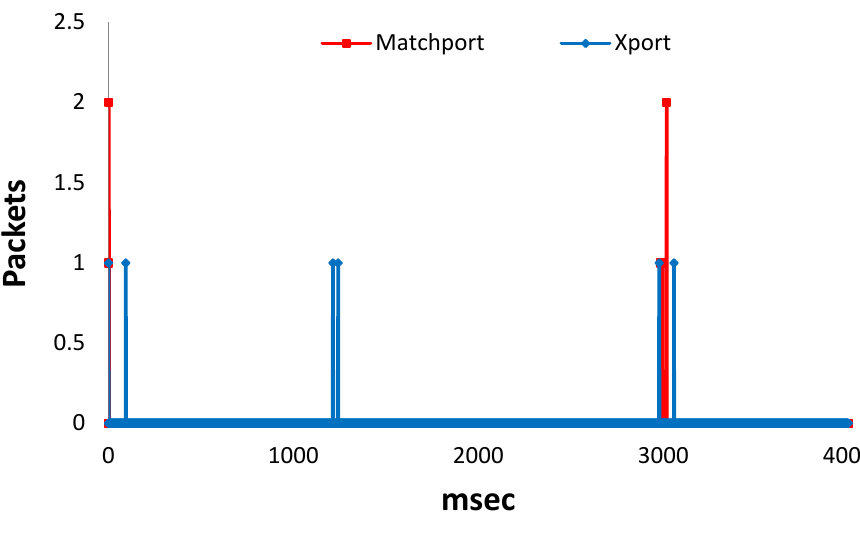
Figure 15. Packets received per millisecond in proactive mode.